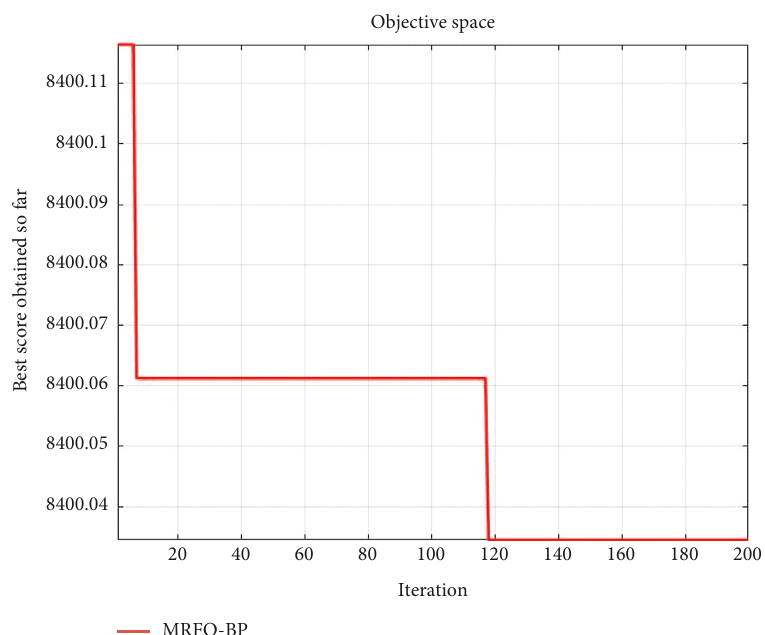
Figure 10: Historical optimal position curve of the